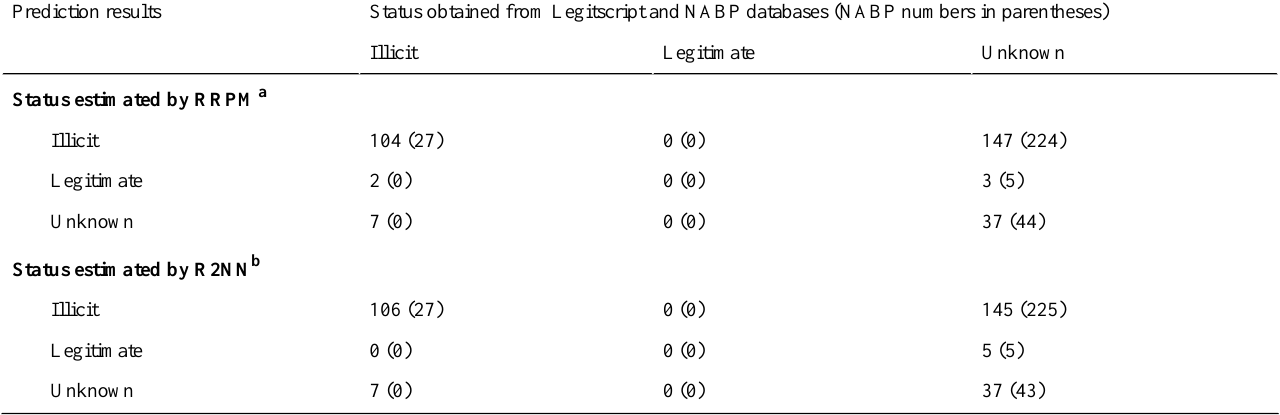
Table 9. Comparison of the predicted status of online pharmacies based on reference rating prediction method (RRPM) and reference-based K-nearest neighbor (RKNN) with those obtained from Legitscript and National Association Board of Pharmacies (NABP) databases, with NABP numbers in